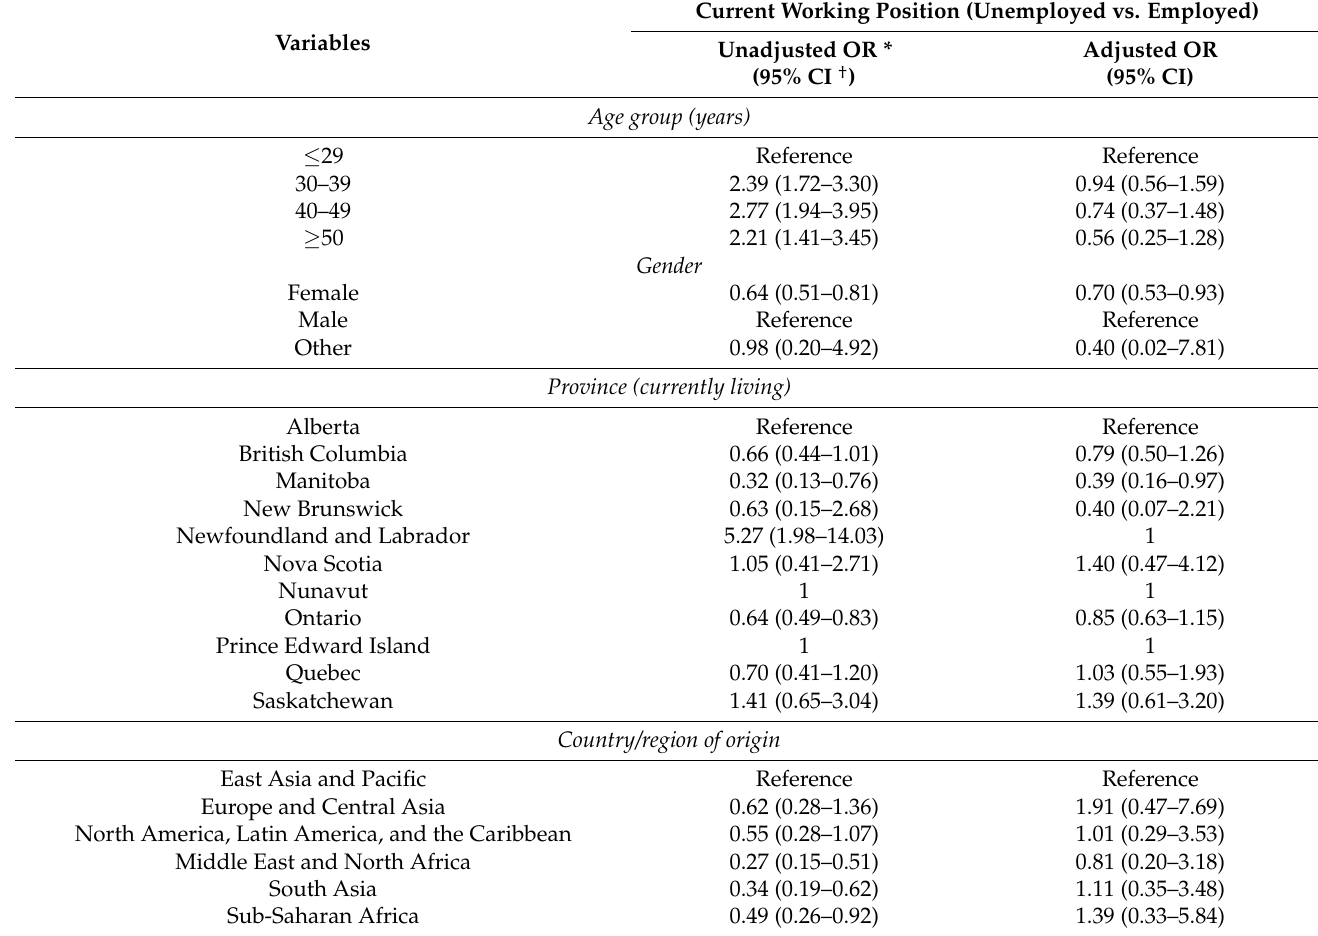
Table 2. Factors associated with being employed among the survey respondent